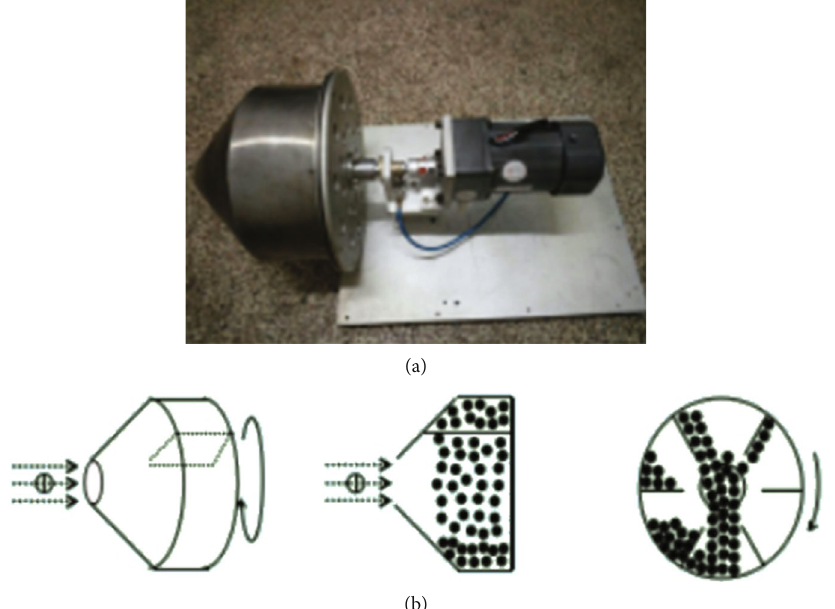
Figure 1: The physical picture self-designed carrier (a) and schematic diagram of the magnetron sputtering process (b).